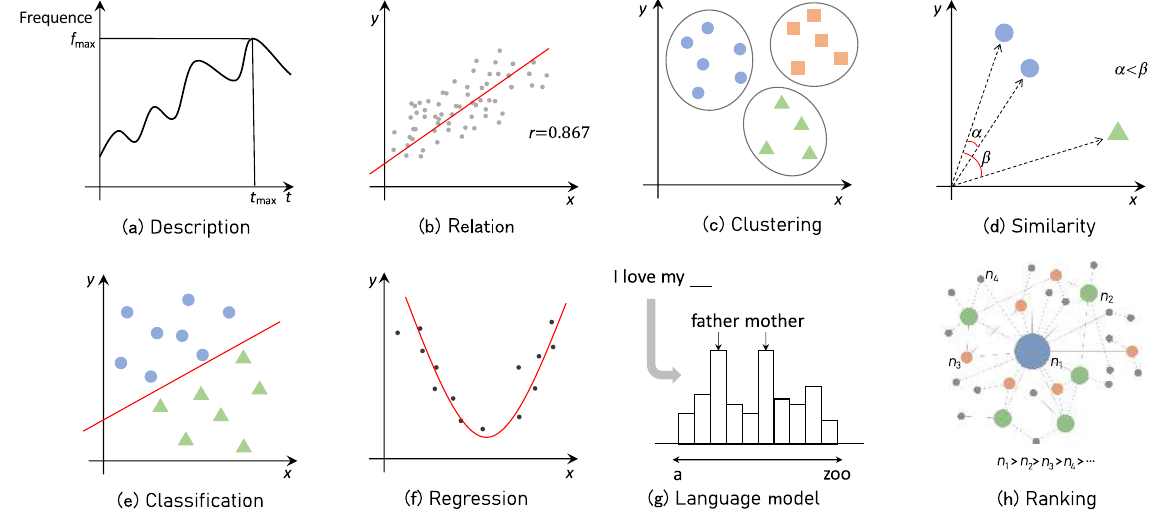
Fig. 16 A simple illustration of eight prototypical